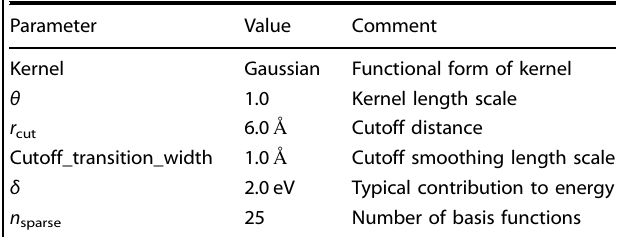
Table 1. Parameters for the two-body GAP